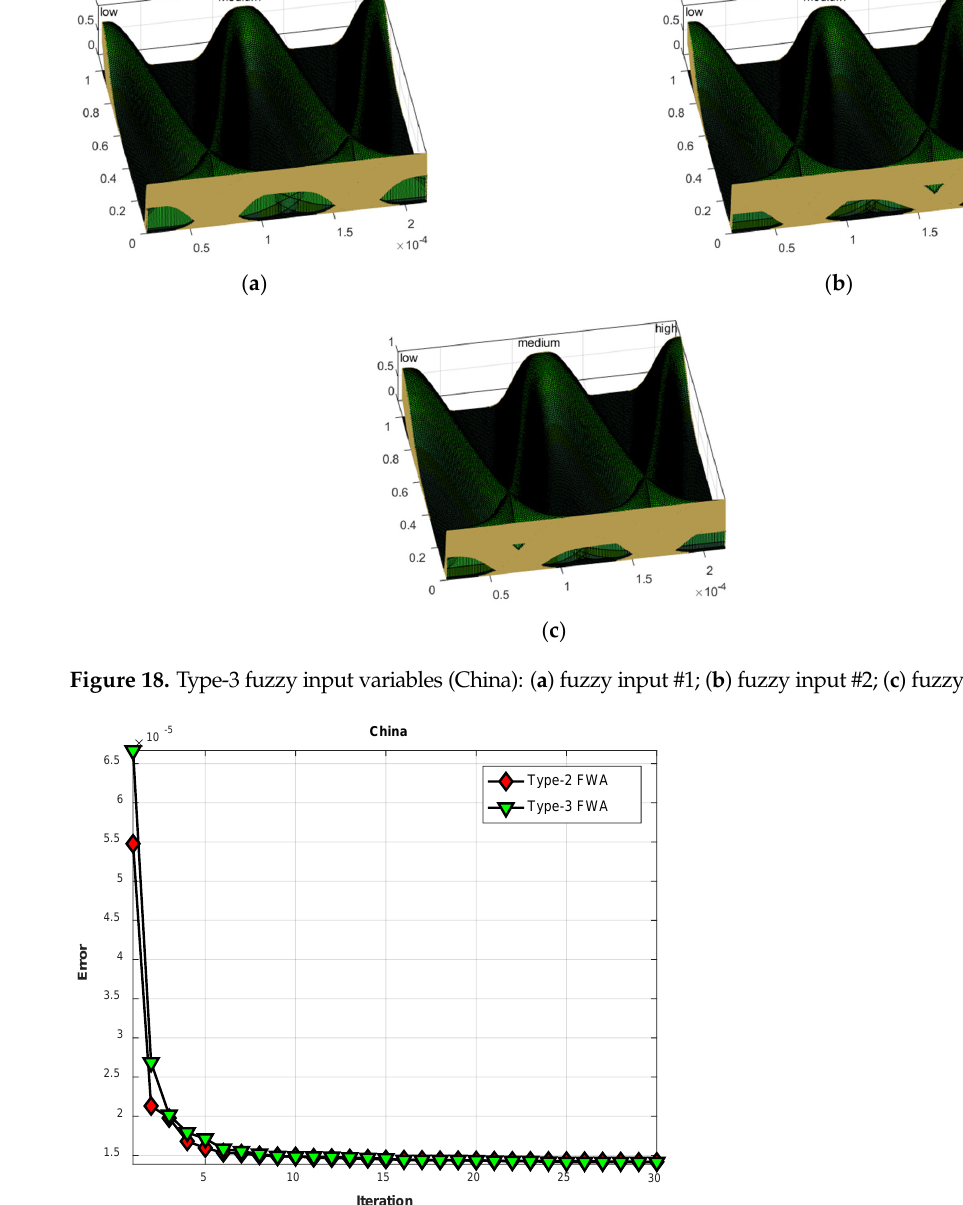
Figure 19. Average convergence for China. Table 7. First data period (testing prediction,